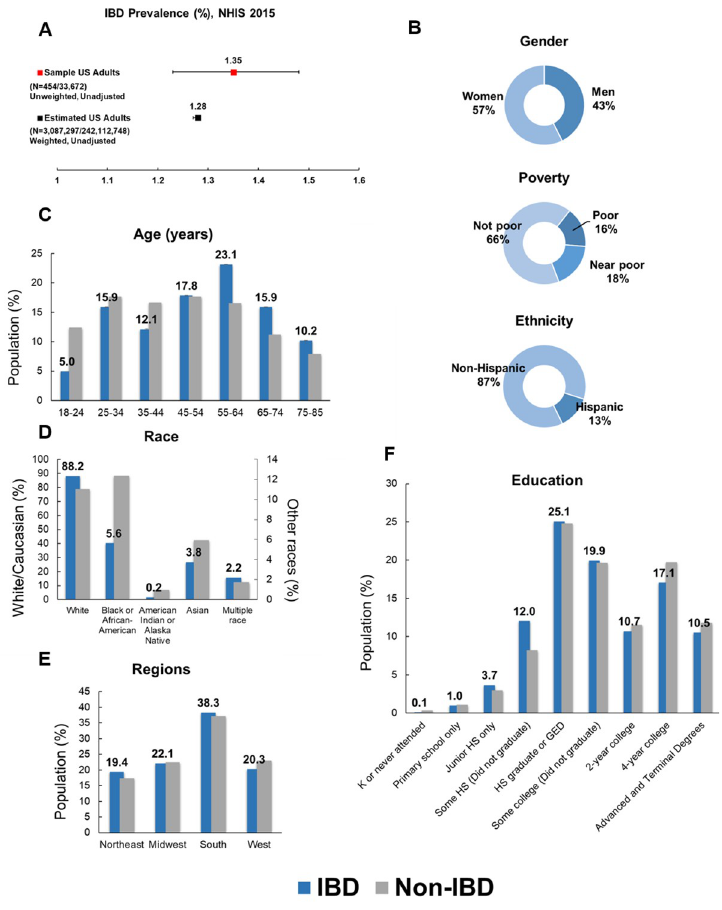
Fig 1. Demography characteristics of estimated US adult population with inflammatory bowel disease (IBD) from National Health Interview Survey (NHIS), 2015. ( A ) IBD prevalence (%) in sample US adult survey participants and estimated US adult population. B ) Distribution of gender, poverty status, and ethnicity shown in percentages. ( C ) Age, ( D ) race, ( E ) regions of residence, and ( F ) education. Values in panels C, D, E, and F reflect those of IBD population. Error bars indicate lower and upper bound of 95% confidence interval. N = (Number of people with IBD/Total number) � Asterisks indicate statistically significant difference (p-value < 0.05) when compared to estimated non-IBD